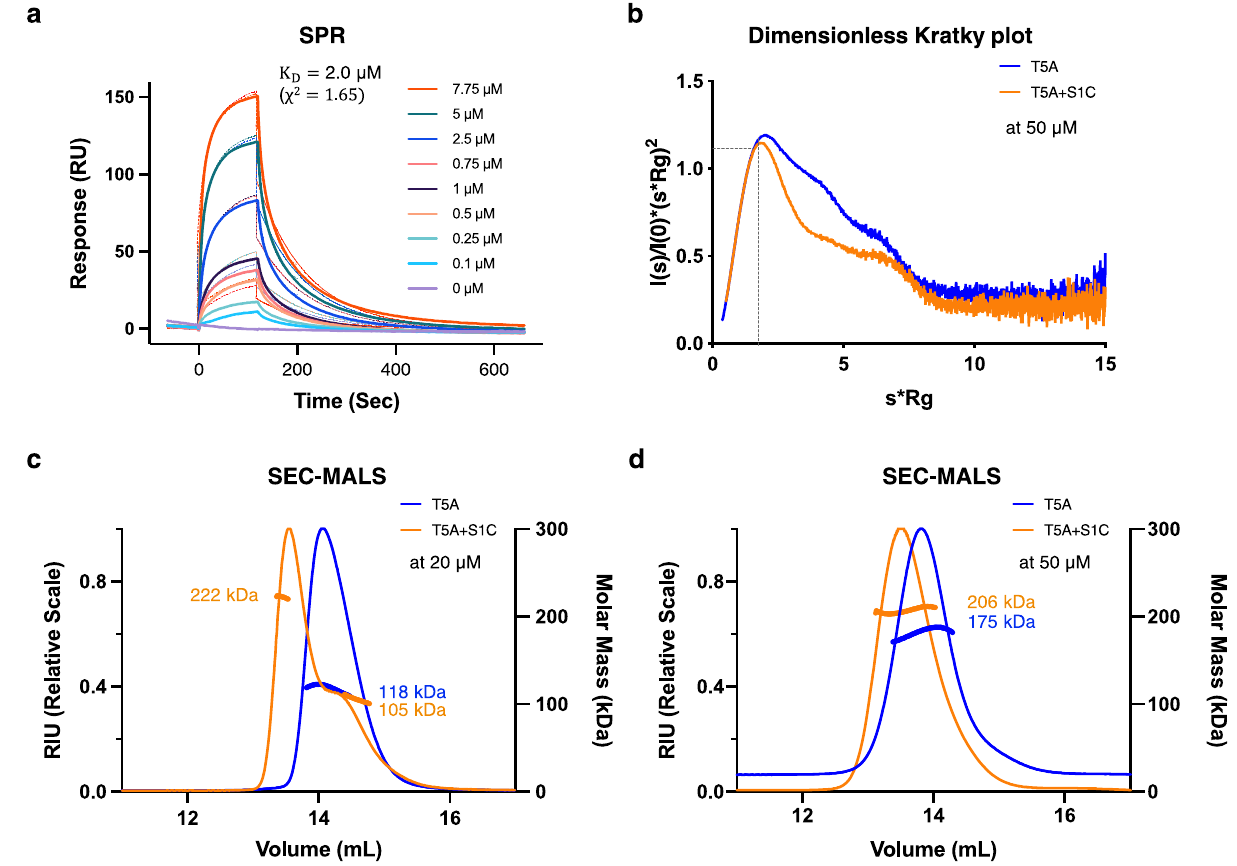
Fig. 3 | Spz1C low af fi nity binding to Toll5A homodimer decreases protein complex fl exibility.a SPRbindinganalysis.SensorgramsofToll5A(acronym,T5A) run over a range of concentrations (0.1 – 7.5 μ M) on an amine coupled Spz1C-chip (acronym,S1C). b SEC-SAXSdimensionlessKratkyplotanalysisat50 μ